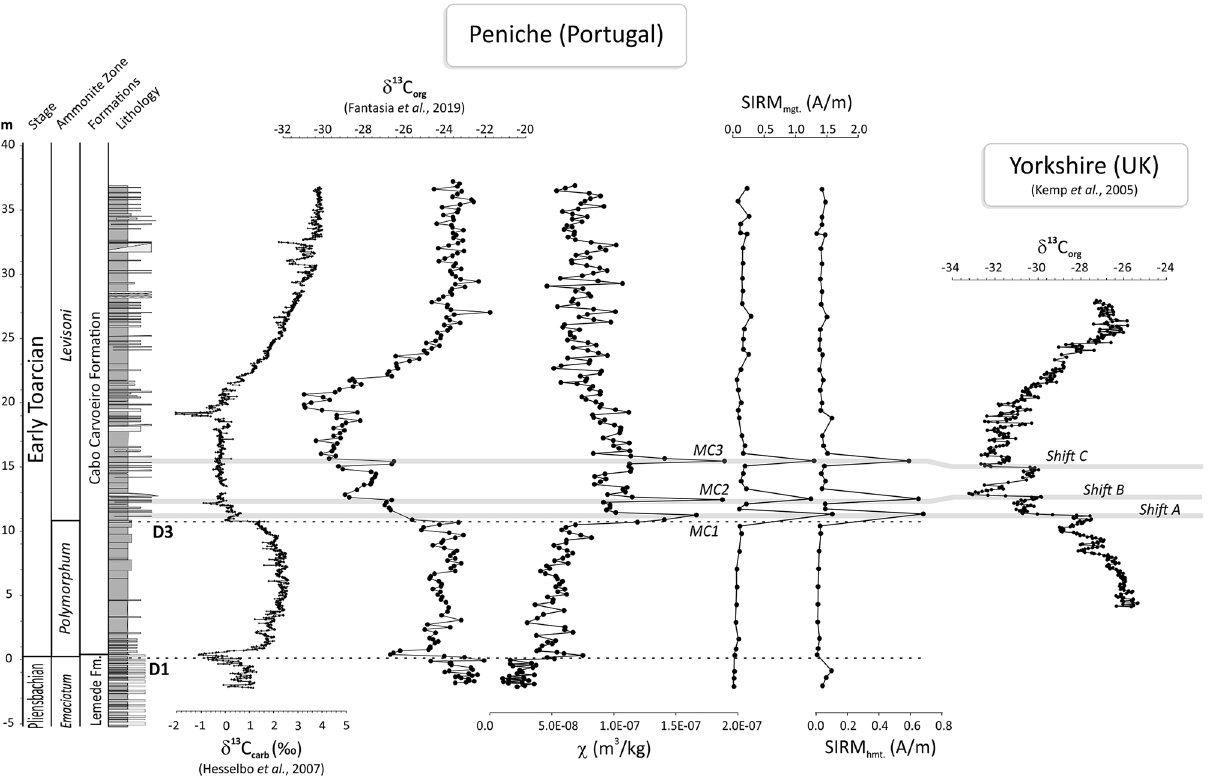
Figure 2. Peniche section: Mass specific magnetic susceptibility ( χ ) and Isothermal Remanent Magnetization (IRM) parameters after unmixing using the Kruiver et al. 96 software. SIRM is the saturation of isothermal remanent magnetization. Isotope composition of carbonate (δ 13 C carb ) and organic carbon (δ 13 C org ) are from Hesselbo et al. 103 and Fantasia et al. 31 , respectively. δ 13 C org shifts identified at Yorkshire (UK, Ref. 8 ) are shown for comparison. MC1, MC2, and MC3 correspond to the three brownish layers studied here (see also Fig. 3). D1 and D3 correspond to the discontinuities proposed by Pittet et al. 44